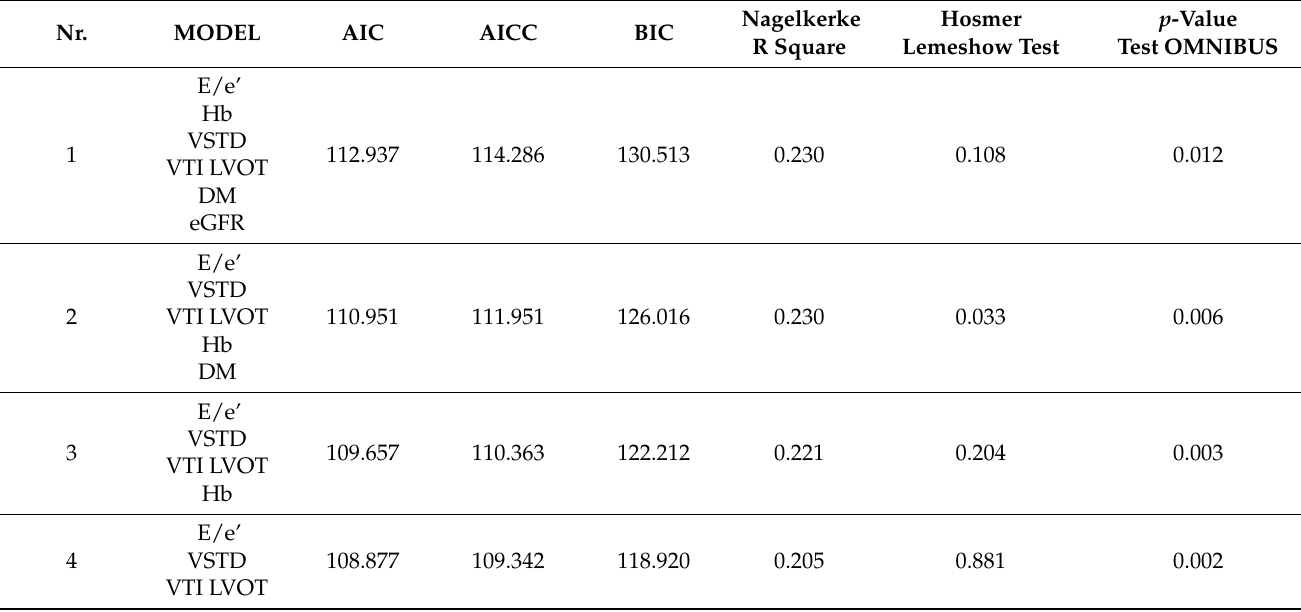
Table A4. Goodness of Fit assessment of the models. The AIC and BIC tests.